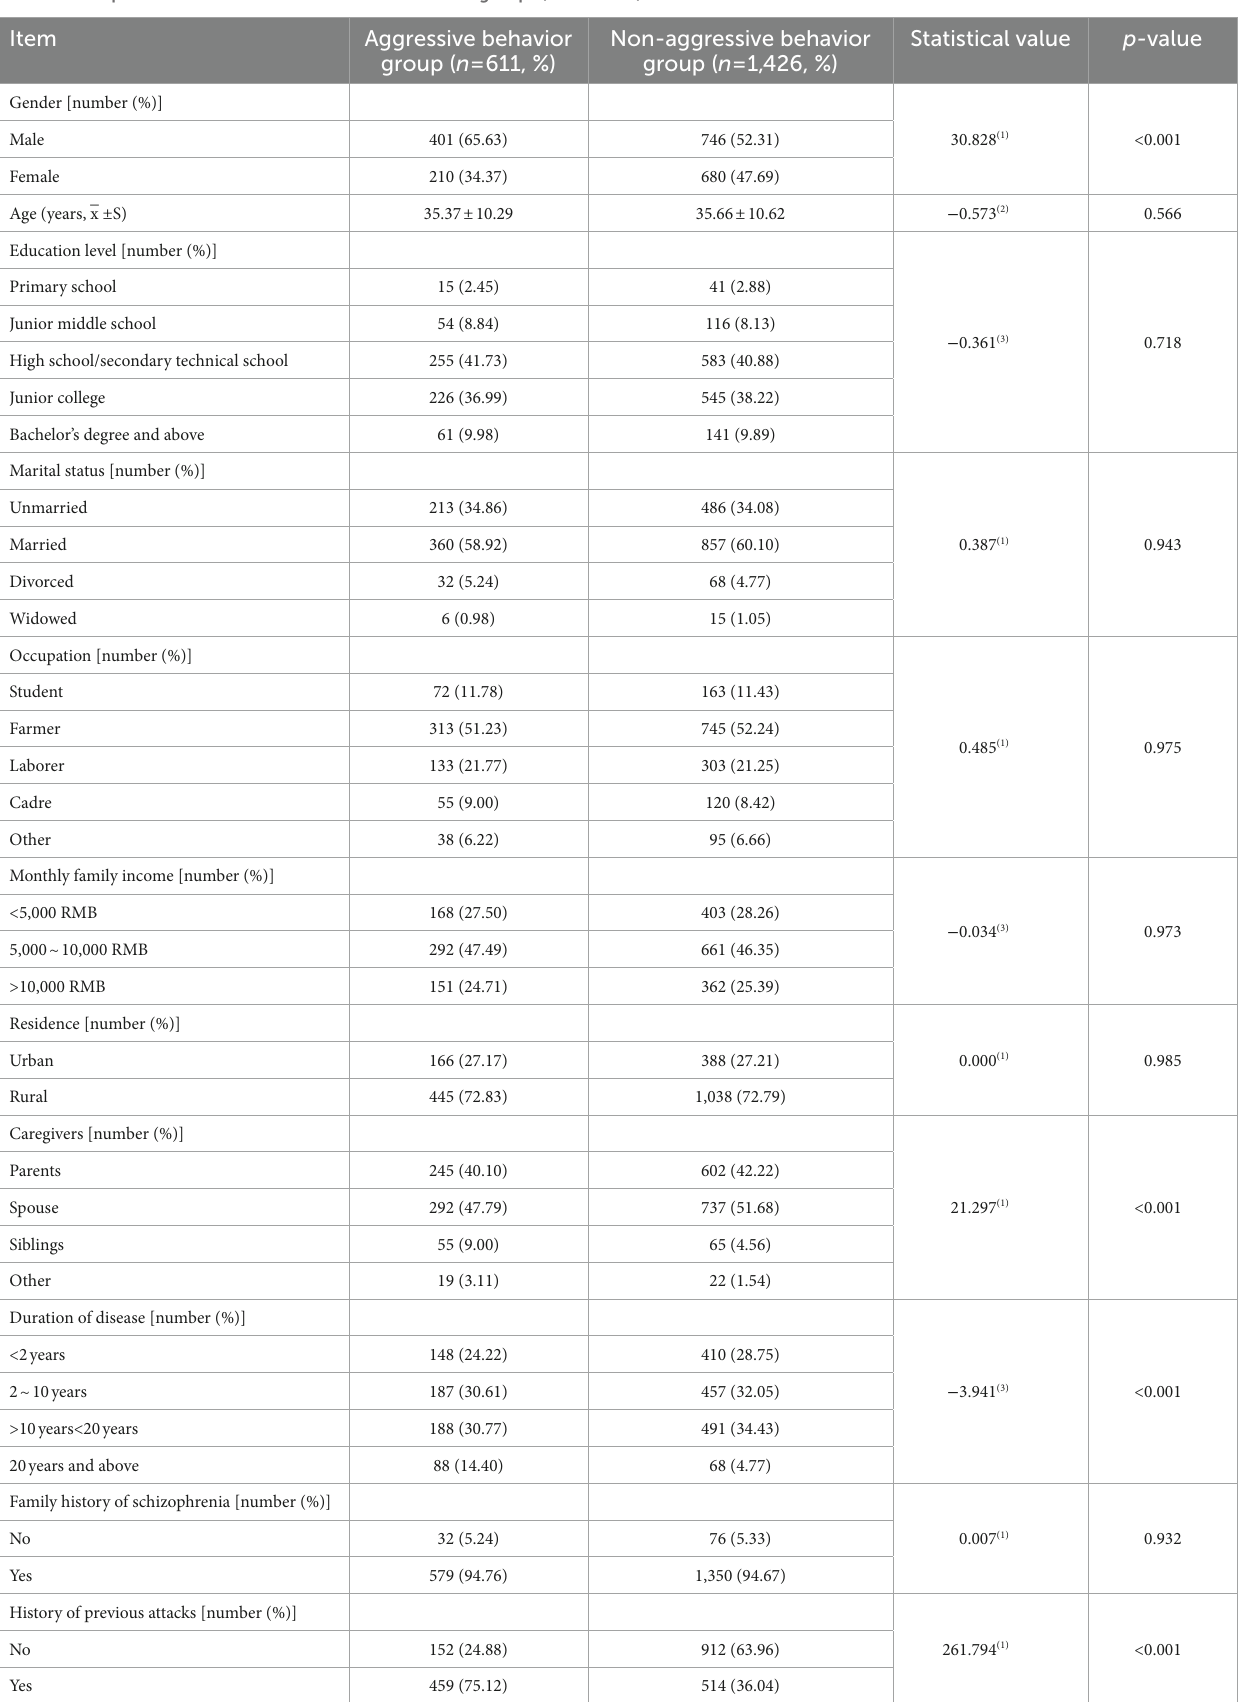
TABLE 2 Comparison of basic conditions between the two groups (num = 2037). Item Aggressive behavior